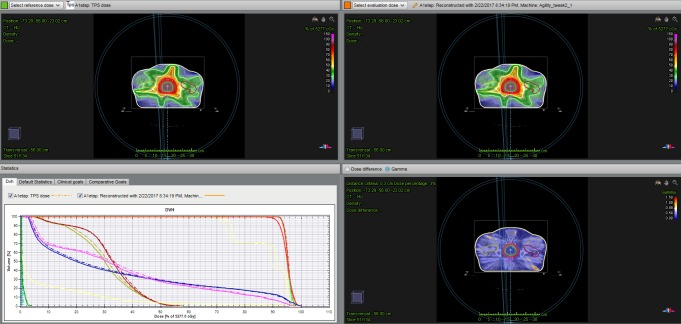
3D gamma index (GI) analysis in the Compass system on a patient’s CT scan with evaluation of DVHCompass versus DVHTPS in a patient with prostate cancer.